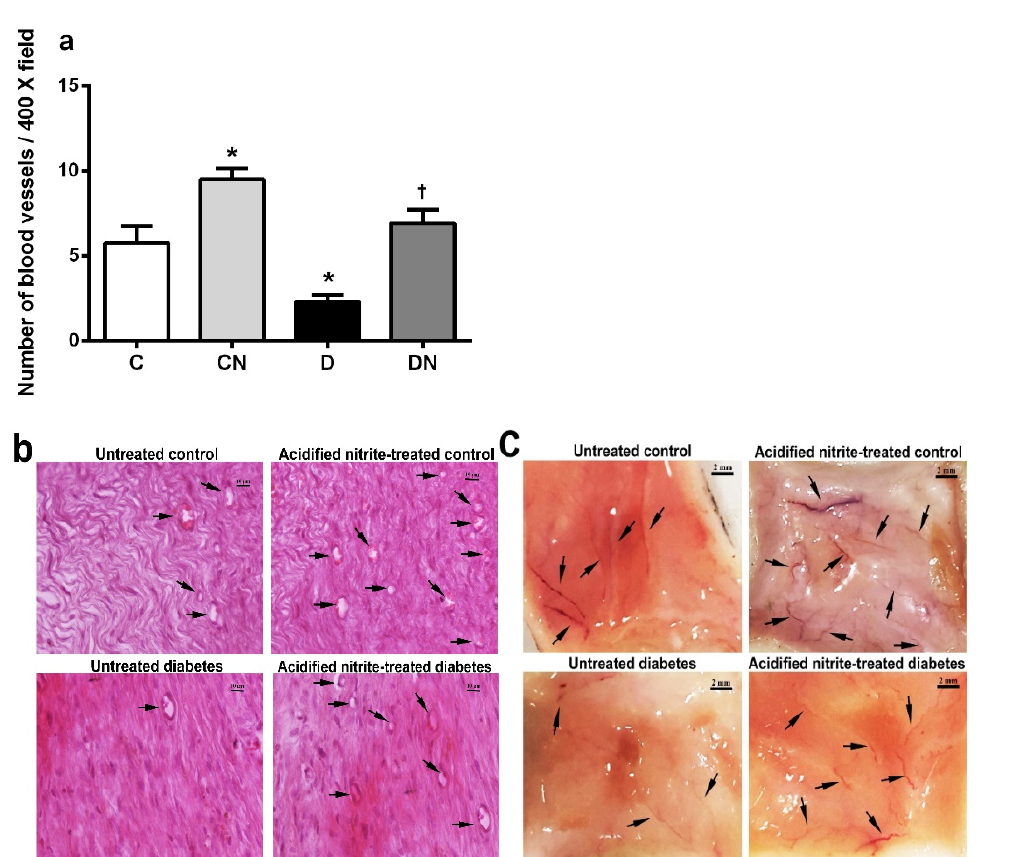
Figure 6. Effect of the topical acidified nitrite application on the number of blood vessels ( n = 6/subgroup) ( a ). Representative images of H&E-stained sections at day 21 after wounding (400 × magnification and scale bar = 10 µ m) ( b ). Representative macroscopic images of skin at day 21 after wounding (scale bars = 2 mm) ( c ). Arrows, microvessels; C, untreated control; CN, acidified nitrite-treated control; D, untreated diabetes; and DN, acidified nitrite-treated diabetes. * p < 0.05 compared to untreated control rats, and † p < 0.05 compared to untreated diabetic rats. Values are the mean ± SEM.